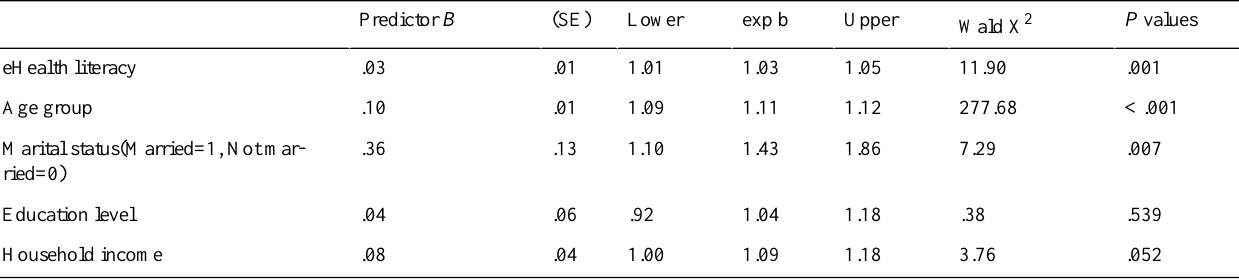
Table 6. Adjusted odds ratios for CRC screening practice by eHealth literacy level.